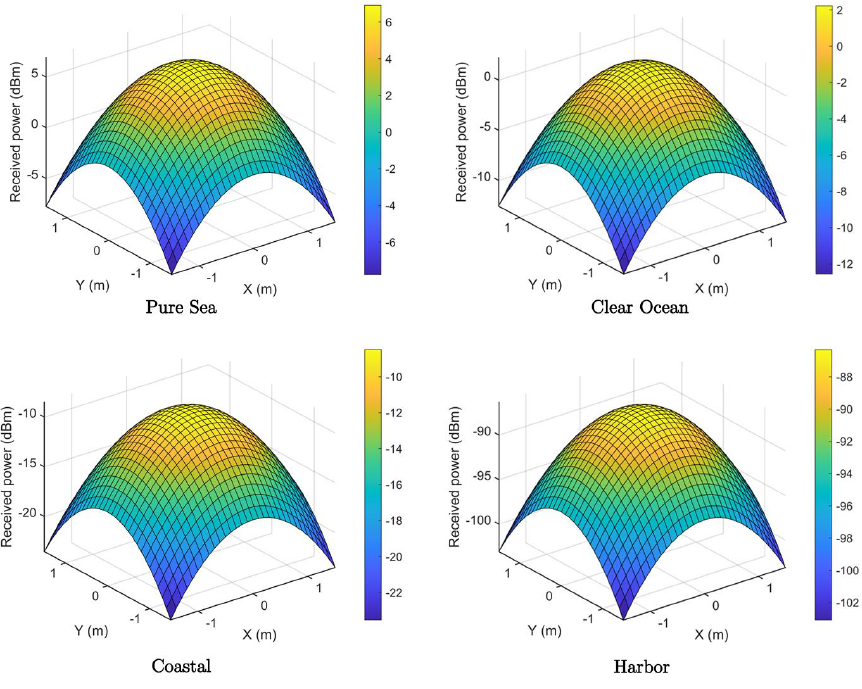
Figure 9. Spatial distribution of optical power in the received plane.